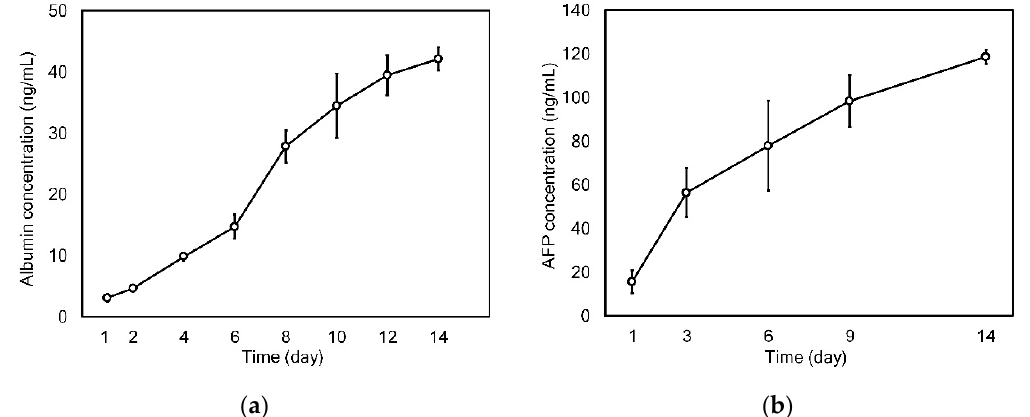
Figure 8. Real-time monitoring of secretion of ( a ) albumin and ( b ) AFP for 14